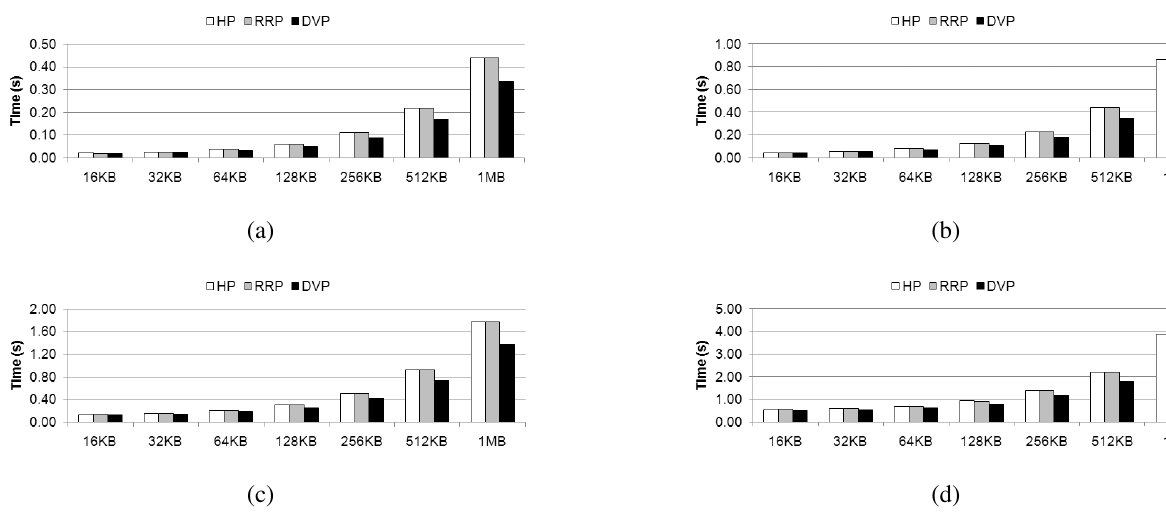
Figure 10. Decoding time of HP, RRP, and DVP on the Cell BE with various